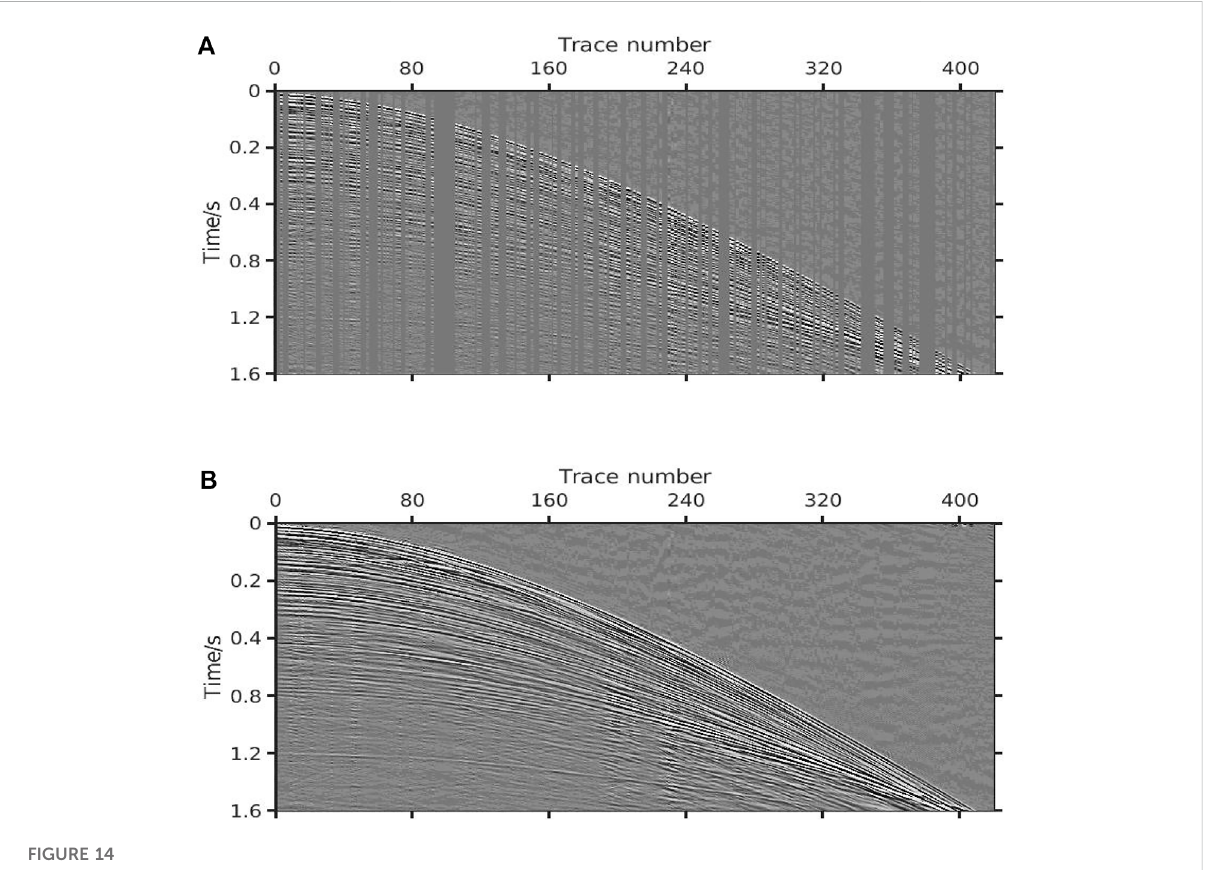
FIGURE 14 Regularized reconstruction of real data. (A) Original data (SNR=2.16 dB PSNR=11.2 dB). (B) Reconstructed data (SNR=23.89 dB PSNR=32.92 dB).